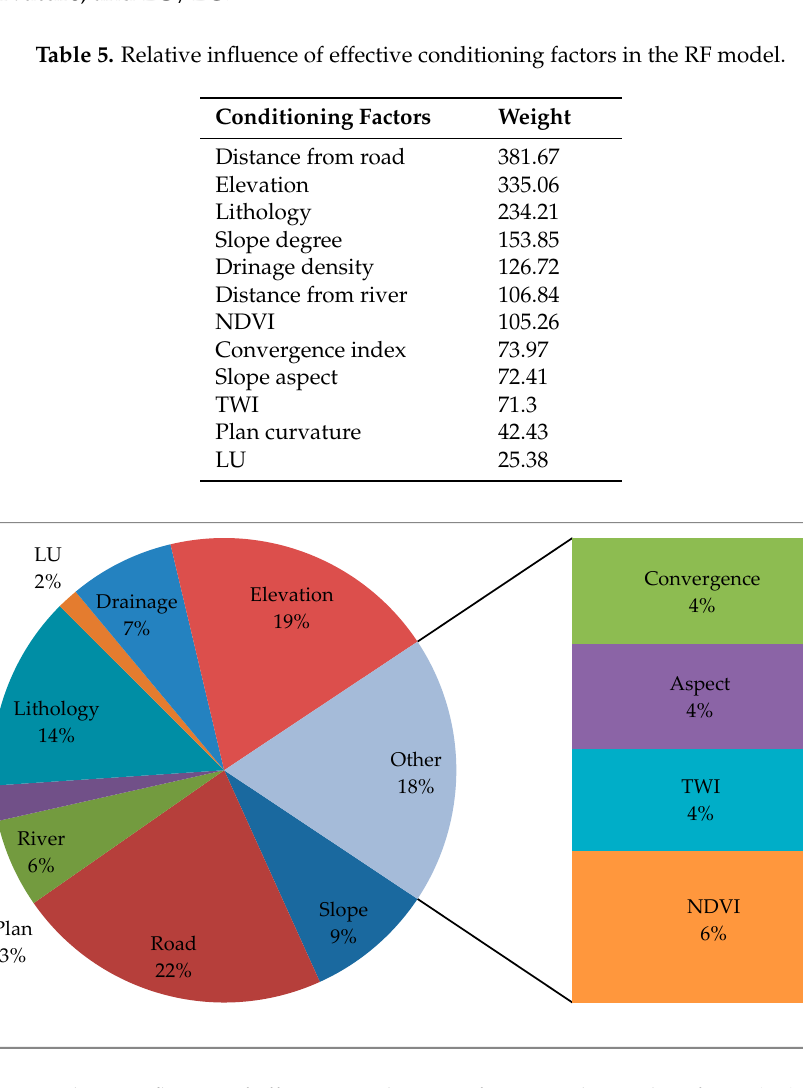
Figure 4. Relative influence of effective conditioning factors in the random forest (RF) model. Table 4. Confusion matrix from the random forest (RF) model (0 = no gully, 1 = gully).